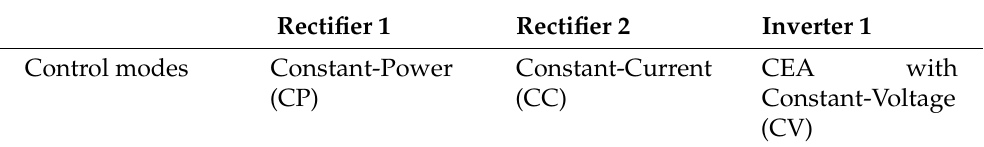
Table 3. Control mode configuration for the HVDC multi-terminal tutorial example test